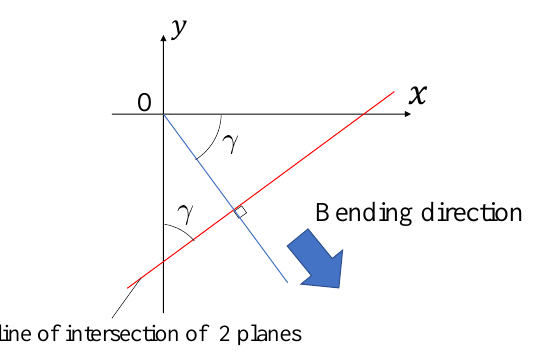
Figure 7. Bending direction angle.